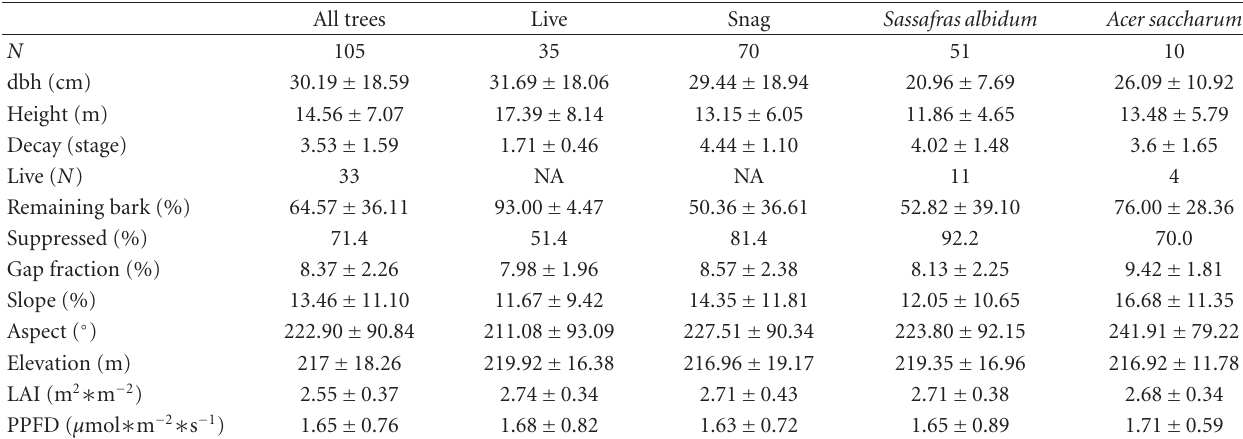
Table 3: Mean ± SD values of day-roost characteristics for all trees, live and snag trees, and the two tree species most commonly used by